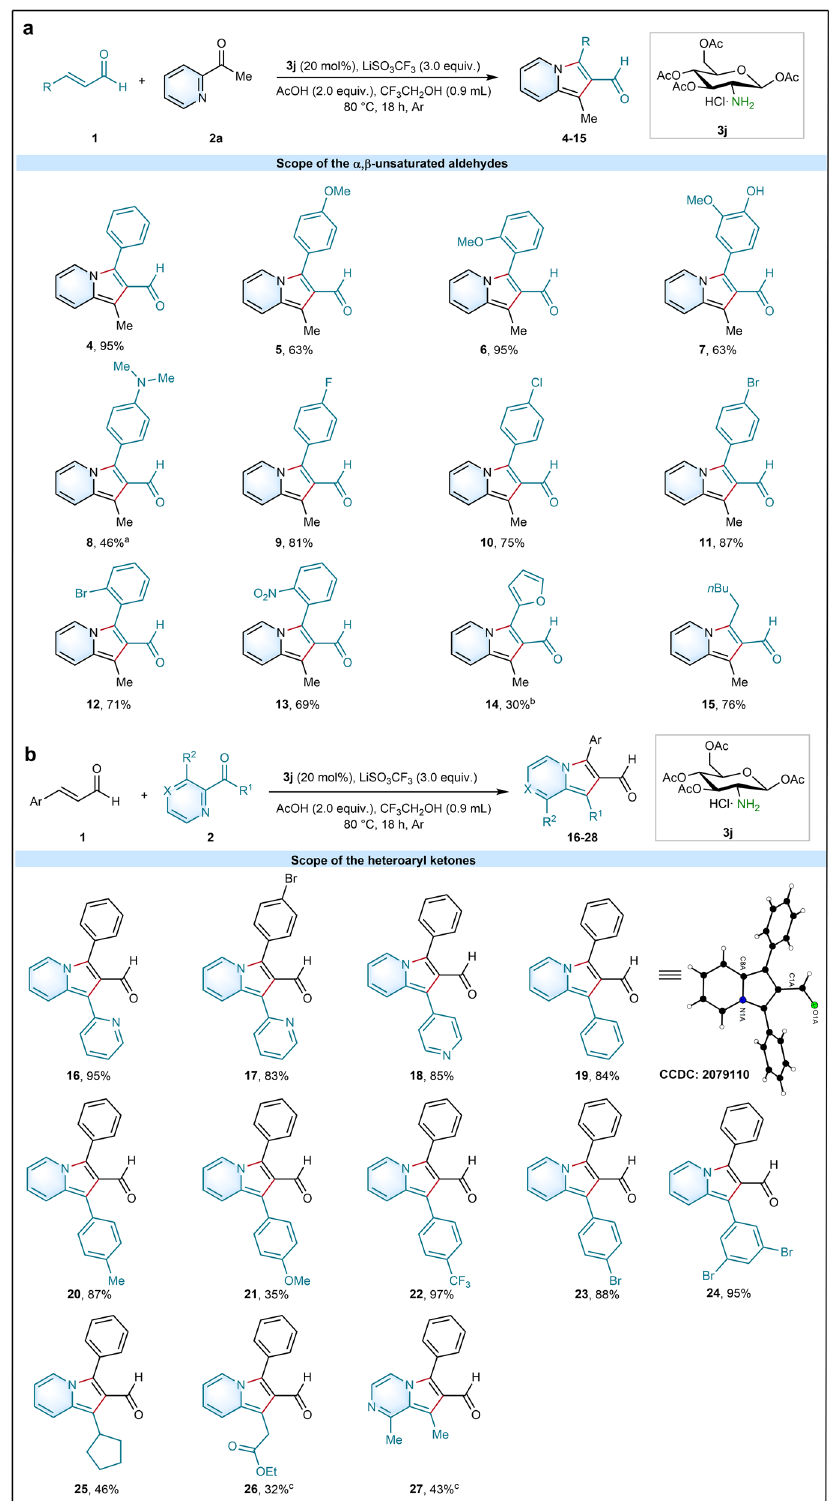
Fig. 3 Scope of substrates for the synthesis of indolizine-2-carbaldehydes. a Scope of aldehydes. b Scope of the heteroaryl ketones. Unless otherwise speci fi ed, all products were prepared with General procedure A : α , β -unsaturated aldehyde (0.2mmol), heteroaryl ketones (2.5equiv.), catalyst 3j (20mol%), AcOH (2.0equiv.) and LiSO 3 CF 3 in CF 3 CH 2 OH (0.9mL) for 18h at 80°C under Ar atmosphere. a General procedure B : α , β -unsaturated aldehyde (0.2mmol), heteroaryl ketones (2.5equiv.), catalyst 3j (20mol%), and LiSO 3 CF 3 in AcOH : CF 3 CH 2 OH (0.4 : 0.5mL) for 36h at 80°C under Ar atmosphere. b General procedure C : α , β -unsaturated aldehyde (0.2mmol), heteroaryl ketones (2.5equiv.), catalyst 3j (20mol%), AcOH (4.0equiv.) and LiSO 3 CF 3 in CF 3 CH 2 OH (0.9mL) for 42h at r.t.. c General procedure D : α , β -unsaturated aldehyde (0.2mmol), heteroaryl ketones (2.5equiv.), catalyst 3j (20mol%), AcOH (2.0equiv.) and LiSO 3 CF 3 in CF 3 CH 2 OH (0.9mL) for 36h at 80°C under Ar atmosphere. Yields are those of isolated